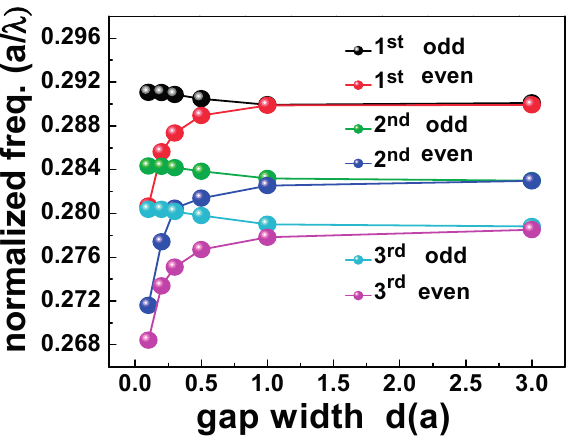
Figure 4. Normalized frequency at different gap width values for first, second, and third even and odd modes in the lateral coupled PhC NB